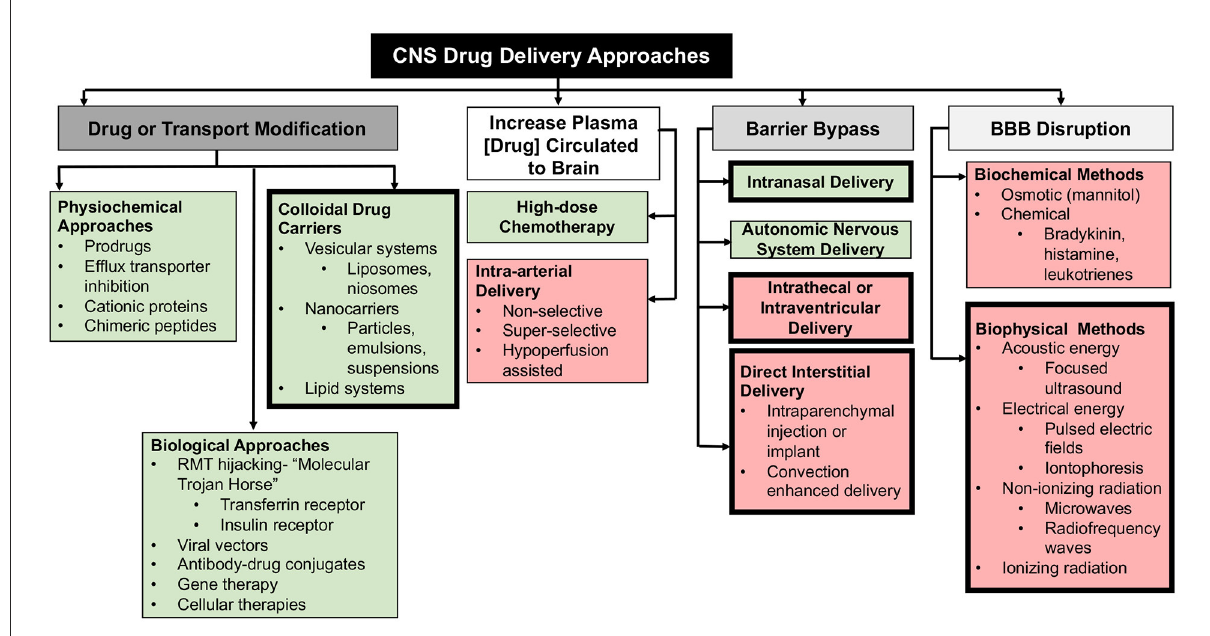
FIGURE3 Mechanistic and methodologic summary of CNS drug delivery techniques. Non-invasive approaches are presented in green boxes, and invasive methods in red. Bold outlined boxes denote techniques that are covered in this